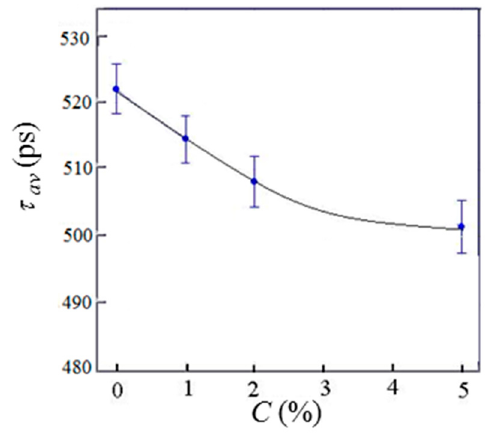
Figure 16. Concentration dependence of the average positron lifetime for MLG–epoxy composites.